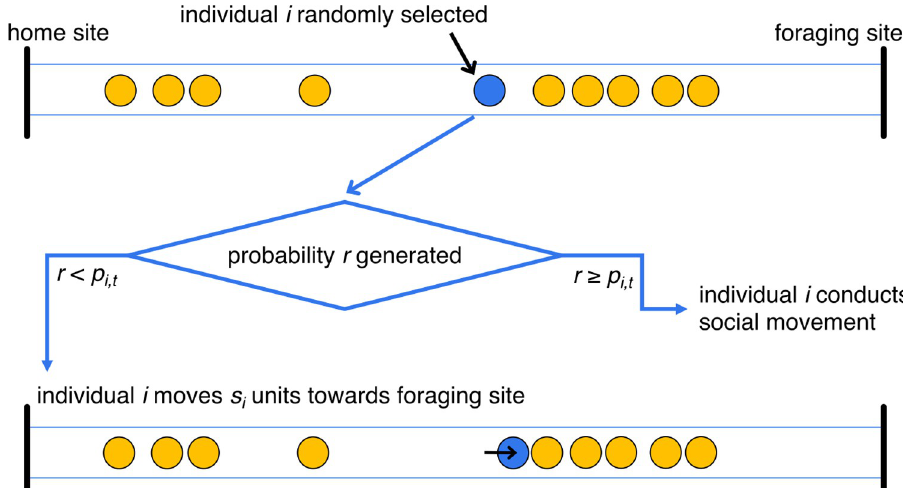
Fig 1. Sketch of the movement decision-generating process. The figure shows an individual who has not yet reached the foraging site, at some intermediate timestep during a simulation. Within a timestep, all individuals make a single movement decision, and the order in which they do this is randomised. If an individual chooses to conduct a social movement, it then moves according to one of the rules sketched in Fig 2.